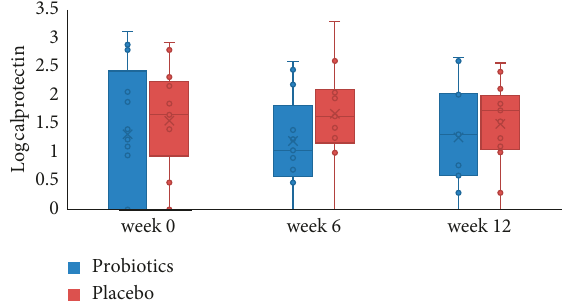
Figure 6: Faecal calprotectin (measured in µ g/g) during the 12- week intervention period in the probiotics and placebo group. The dotted line at log 2 reflects the cutoff for inflammation at 100 µ g/g